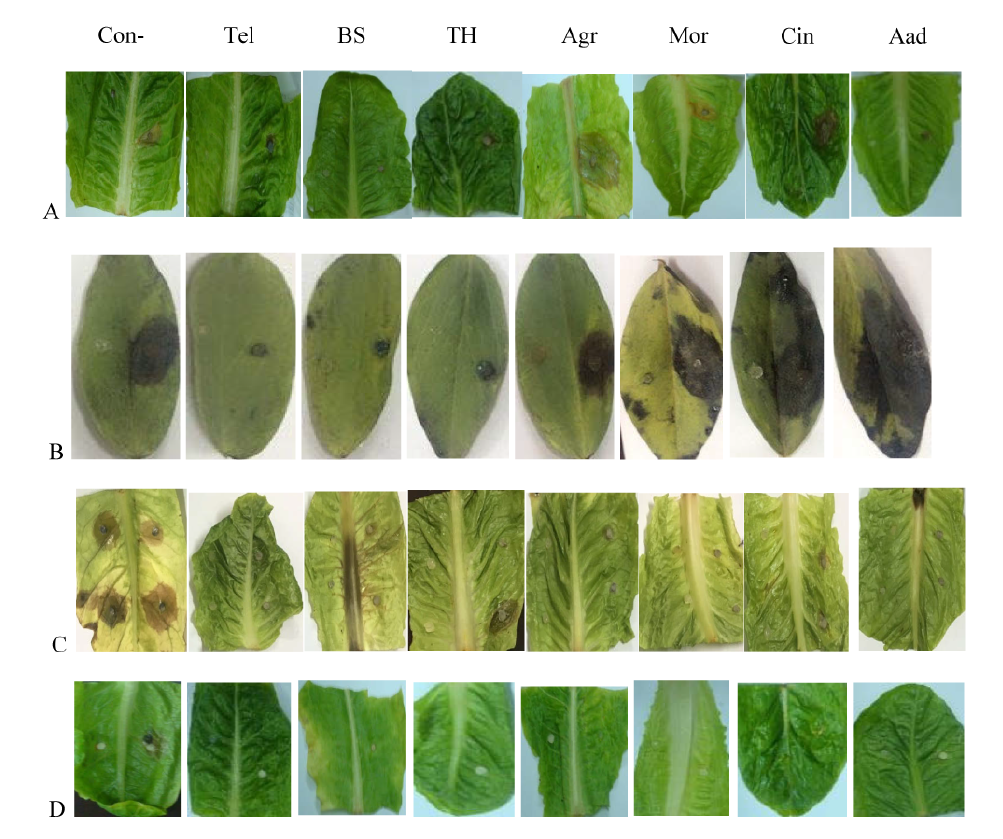
Figure 4 Lesion diameter produced by BCS on two plant species: lettuce ( A ), broad bean ( B ); BCC ( C ) and SSB ( D ) infections on detached lettuce